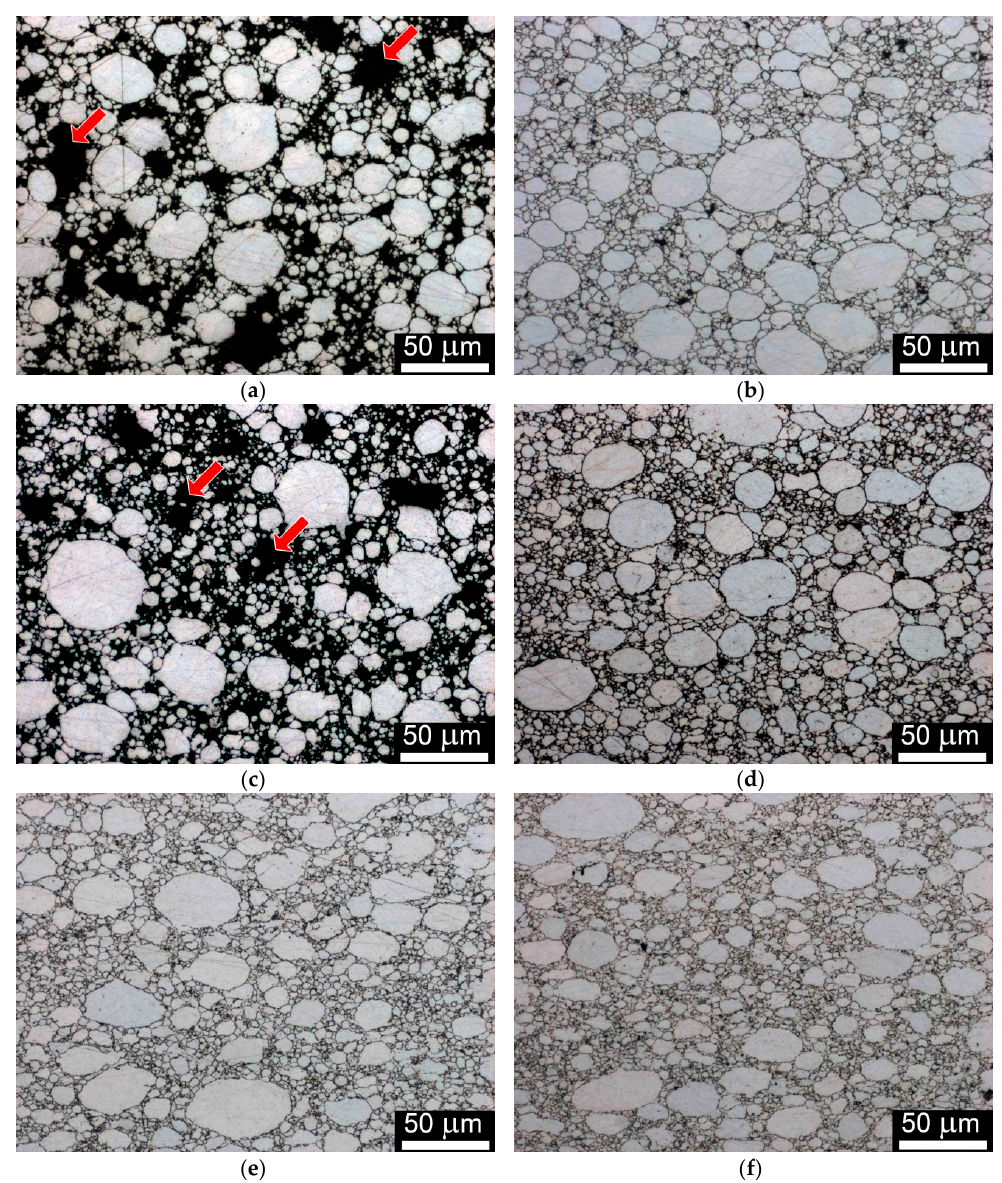
Figure 2. Microstructure of materials prepared from Zn7.5 powder, etched with 5% Nital, optical microscope (OM): ( a ) 100 MPa, CP; ( b ) 500 MPa, CP; ( c ) 100 MPa, CP-S; ( d ) 500 MPa, CP-S; ( e ) 100 MPa, HP; ( f ) 500 MPa, HP (CP: Cold pressing; S: Sintering; HP: Hot pressing).